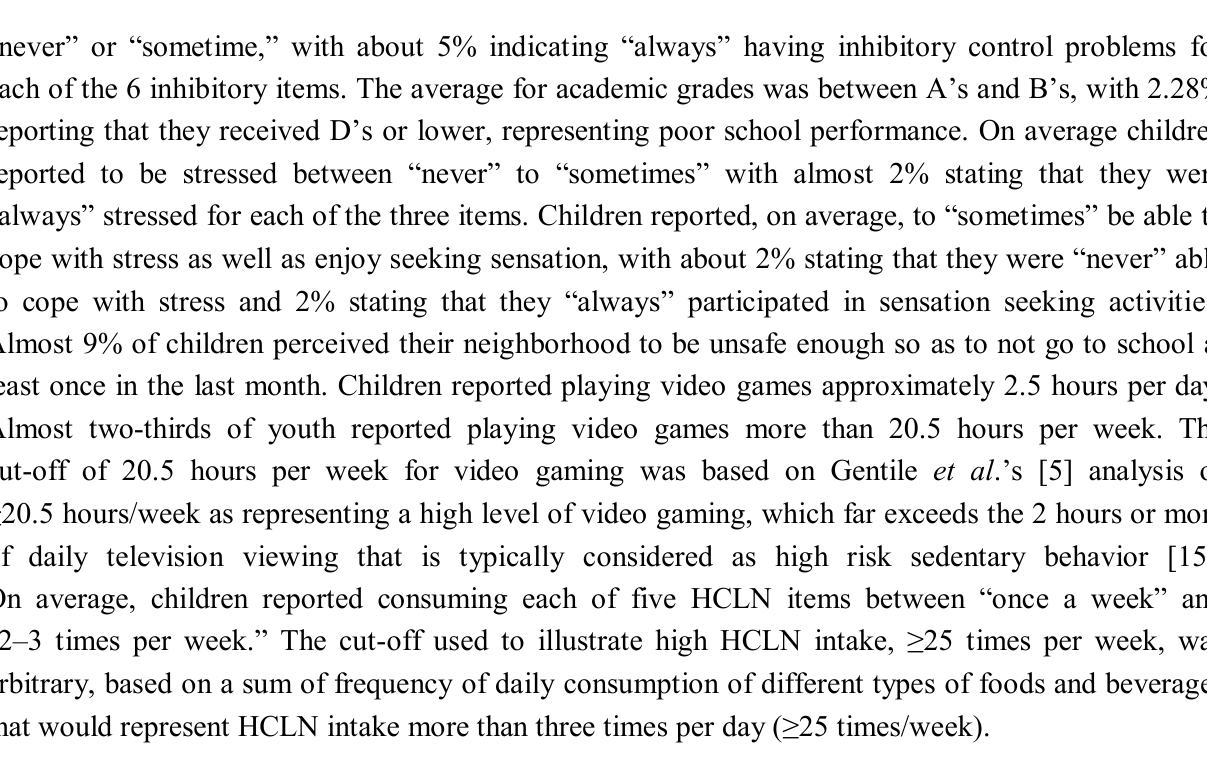
Table 1. Behavioral and demographic characteristics of